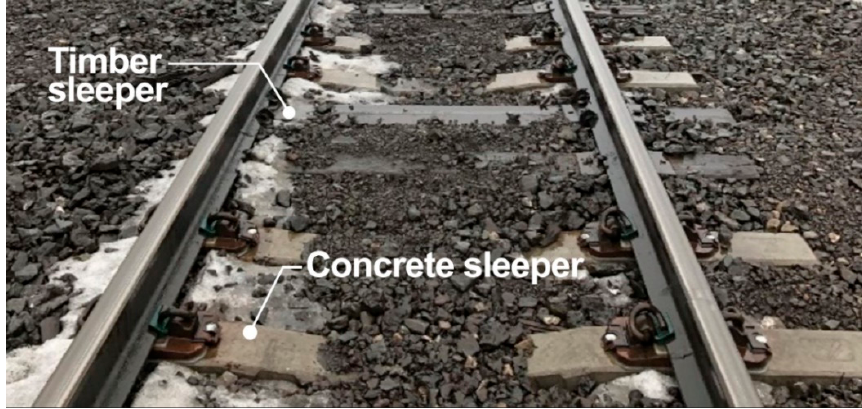
Figure 2. Installation of timber and engineered interspersed concrete (EIC) sleepers.